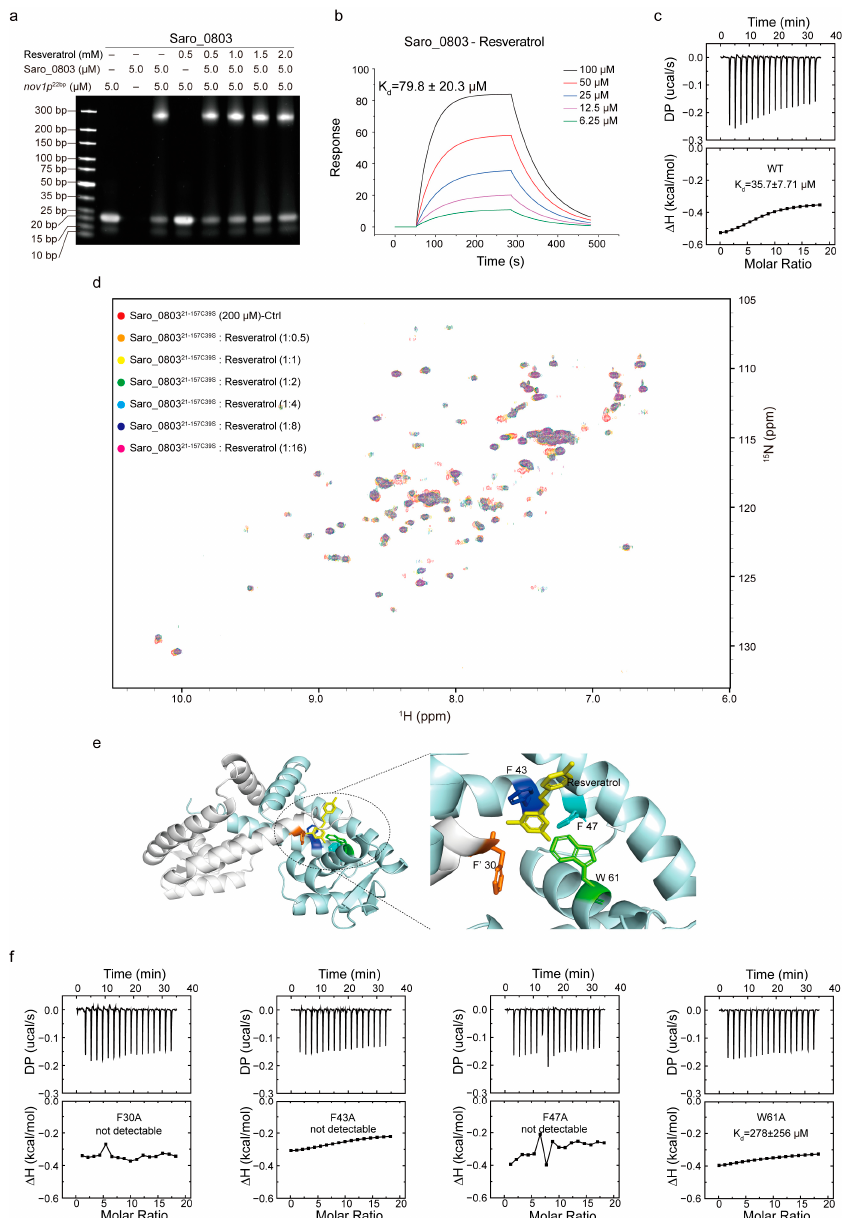
Figure 5. Exploration of the mechanism of resveratrol binding to Saro_0803. ( a ) EMSA analysis to investigate the ligand resveratrol perturbing the Saro_0803– nov1p 22bp binding ability. Incrementally increased concentrations of resveratrol (0, 0.5, 1.0, 1.5, and 2.0 mM) were incubated with 5.0 µM Saro_0803– nov1p 22bp complex. ( b ) SPR experiment with continuous titration of increased concentrations of resveratrol. ( c ) ITC assay of the Saro_0803 titrated with increased concentrations of resveratrol. ( d ) NMR titration experiment illustrated by superimposed 2D [ 1 H- 15 N]-HSQC spectra of Saro_0803 21-157C39S in the absence (red) and presence of incubated resveratrol with increased concentrations, where the protein–ligands ratios were at 1:0.5, 1:1, 1:2, 1:4, 1:8, and 1:16 orange, yellow, green, cyan, blue, and magenta, respectively. ( e ) Molecular docking model of Saro_0803 bound to resveratrol (left panel), and local insight focusing on the presumed protein–ligand binding hotspot (right panel), with the Saro_0803 residues F30, F ′ 43, F ′ 47, and W ′ 61 and resveratrol colored in orange, blue, cyan, green, and yellow, respectively. ( f ) ITC assays of the mutants of Saro_0803 titrated with increased concentrations of resveratrol.